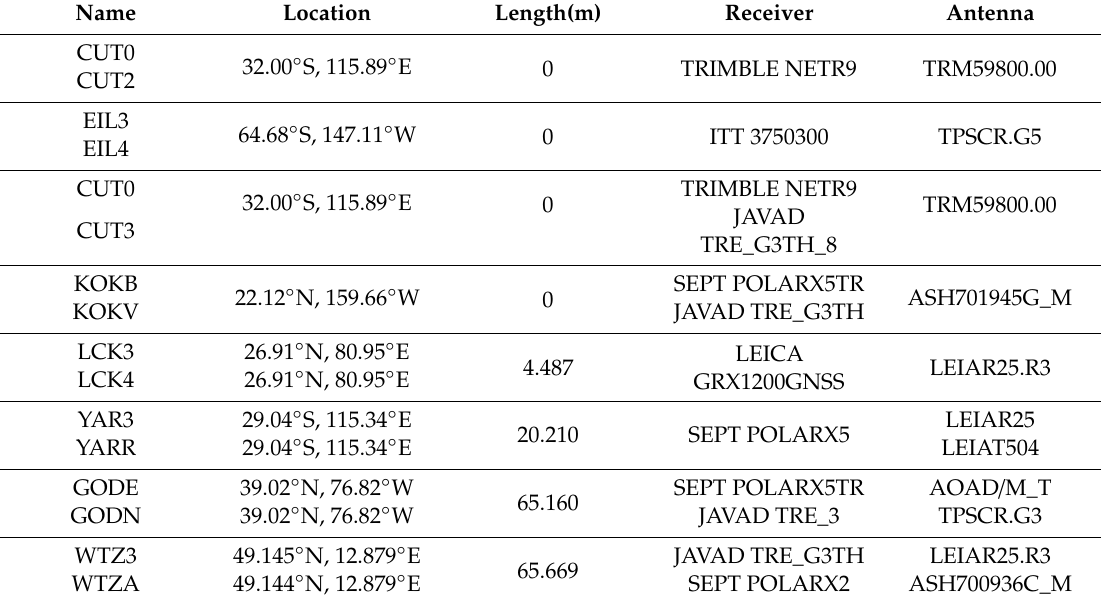
Table 1. The selected stations for accuracy analysis of ionospheric observables obtained from three methods.